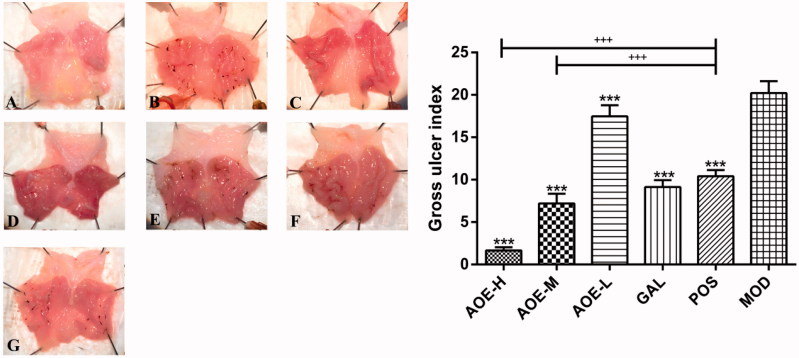
Gross findings of indomethacin-induced gastric damage in the rat gastric mucosa. Normal rat gastric mucosa (A) was damaged by the oral administration of indomethacin (B: 0.3 g/kg), and most of the damage was alleviated by treatment with A. officinarum extract (C: 0.18 g/kg; D: 0.09 g/kg; E: 0.03 g/kg) and galangin (F: 0.2 g/kg) after indomethacin administration. (G) Treatment with 0.08 g/kg bismuth potassium citrate. Healthy rat gastric mucosa in the control group (GUI of 0) are not shown. CON: vehicle control; AOE-H: 0.18 g/kg A. officinarum extract; AOE-M: 0.09 g/kg A. officinarum extract; AOE-L: 0.03 g/kg A. officinarum extract; GAL: 0.2 g/kg galangin; POS: 0.08 g/kg bismuth potassium citrate; MOD: 0.3 g/kg indomethacin. +++p < 0.001 compared with the POS group; ***p < 0.001 compared with the MOD group.